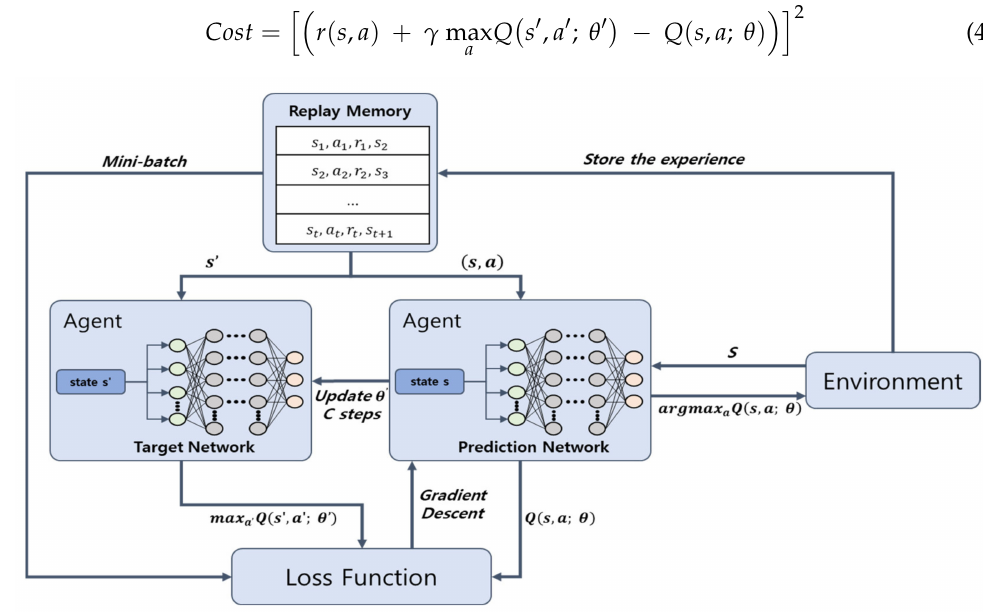
Figure 4. Deep Q-network